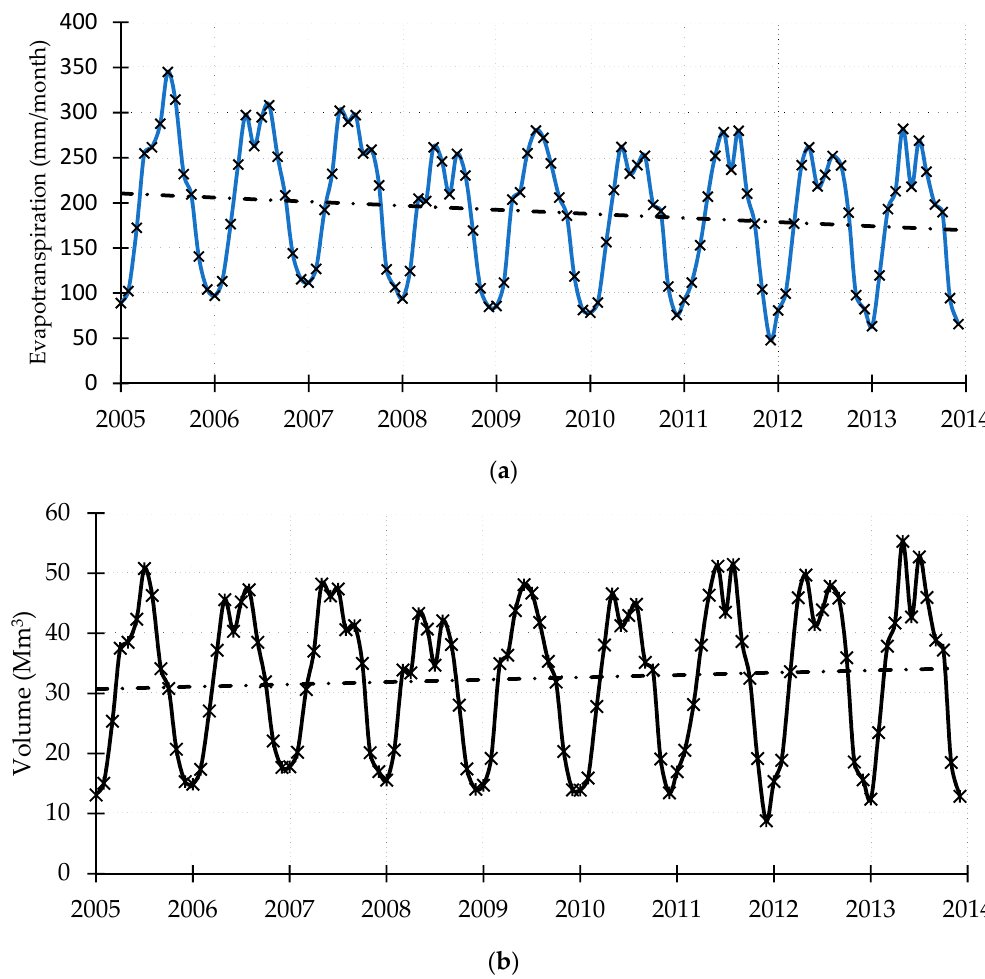
Figure 5. Time series of the monthly evapotranspiration ( a ) in mm/month over agricultural and landscaping area and ( b ) total evapotranspiration volume loss over the watershed (Mm 3 /month).